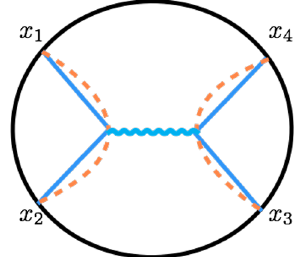
Figure 1 . Geodesic Witten diagram in Euclidean AdS d +1 . A circle represents the AdS boundary, four straight lines are the scalar bulk-to-boundary propagators, and a wavy line is a bulk-to-bulk propagator. Two dashed curves are the geodesics between the boundary points, and the integrals in (2.5) are over the two